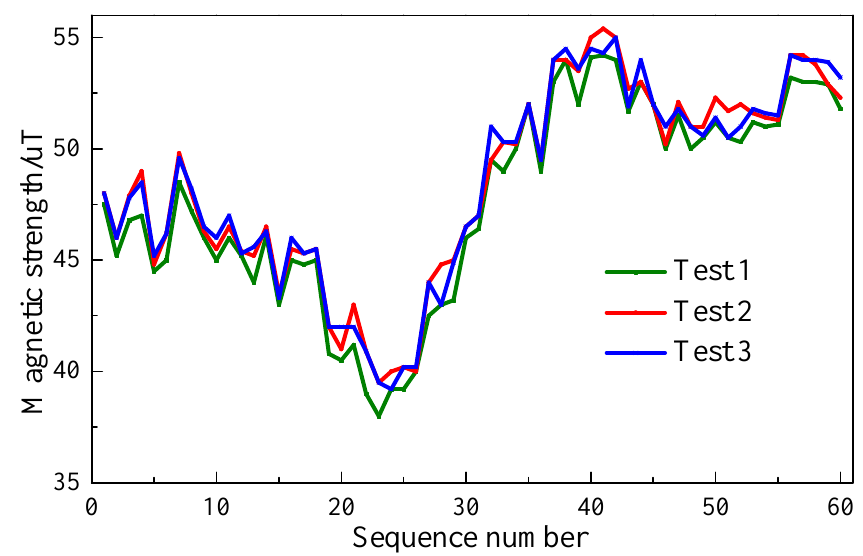
Figure 9. Comparison of indoor magnetic strength of the same path.